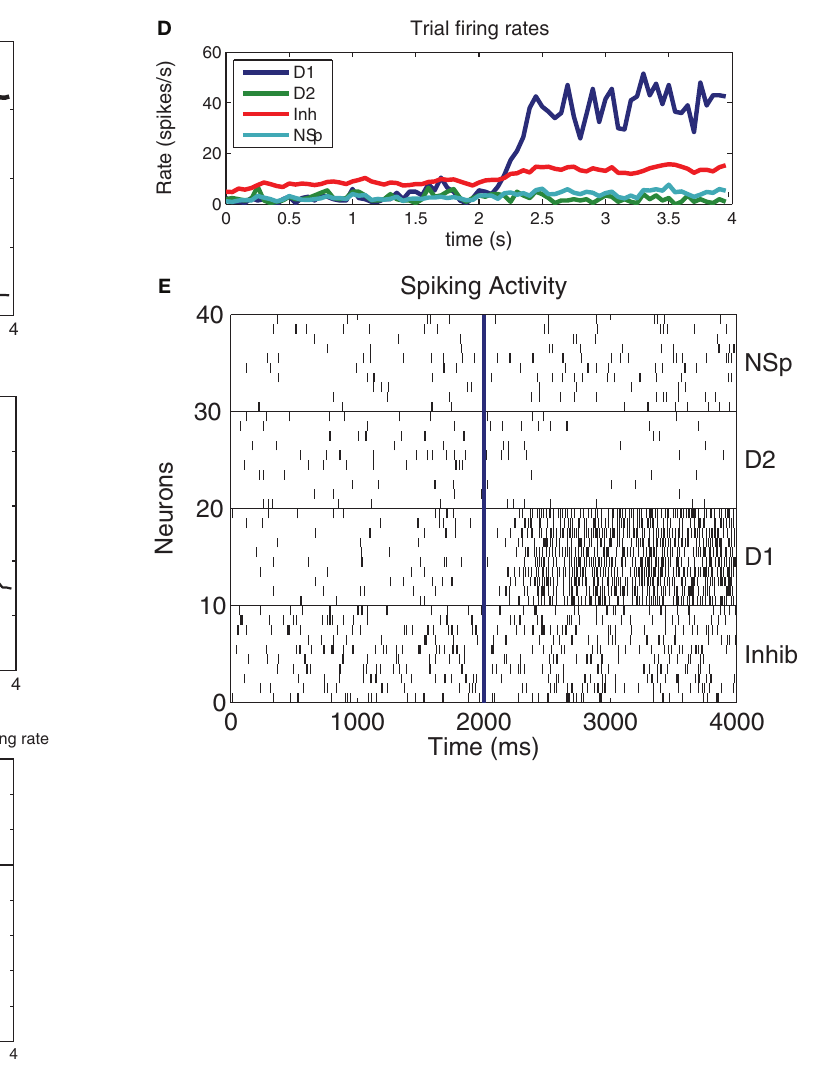
FIGURE 2 | (A) Prediction of a decision before the evidence is applied. In this integrate-and-fire simulation of decision-making, the decision cues were turned on at t = 2s, with (cid:2) I = 0 (i.e., the difference between the decision variables λ 1 and λ 2 was 0). The firing rate averaged over approximately 650 winning vs. losing trials for the attractor shows that the firing rate when the attractor will win is on average higher than that for when the attractor will lose at a time that starts in this case at 300ms before the decision cues are applied. (At t = 2s with (cid:2) I = 0 the input firing rate on each of the 800 external input synapses onto every neuron of both of the selective attractor populations is increased from 3.00 to 3.04 spikes/s, as described in the text). The error bars show the standard deviation of the firing rate calculated across trials for the 50ms bins to indicate the noisy operation of this decision-making system. The large standard deviations in the period after the decision cues are applied at 2s reflect the different decision times of the network on different trials. (B) As (A) , but with an expanded firing rate axis so